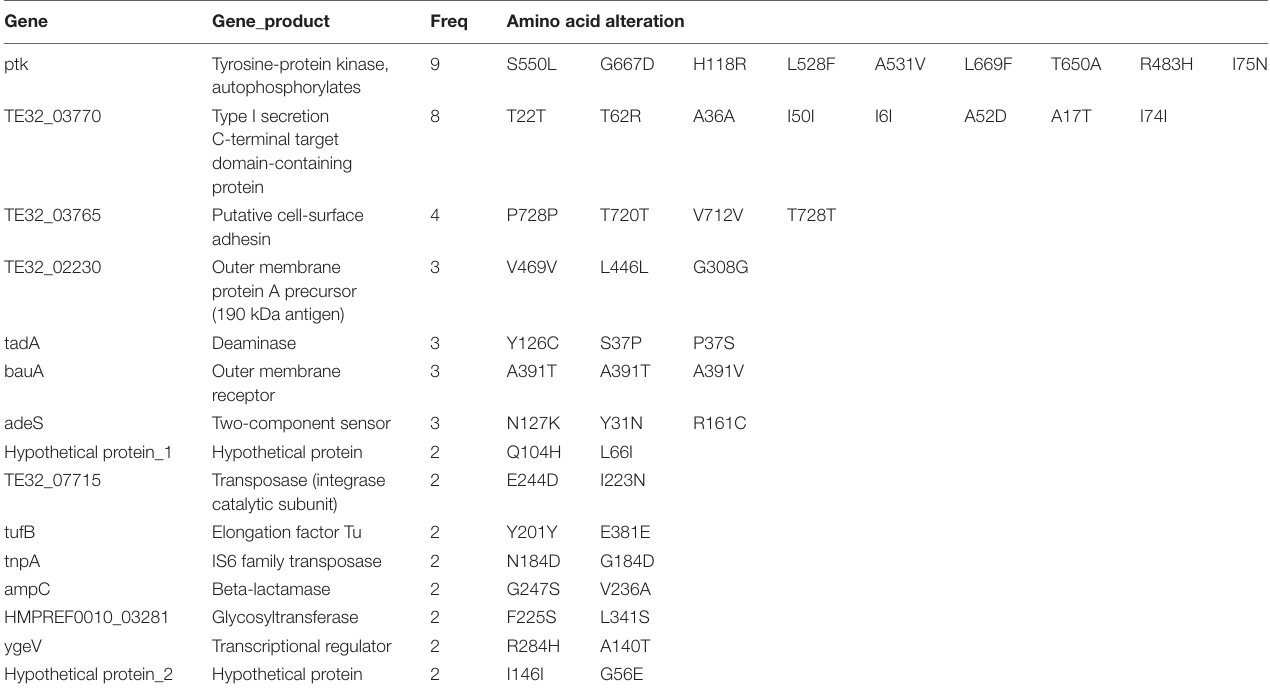
TABLE 1 | The SNPs identified in A. baumannii during